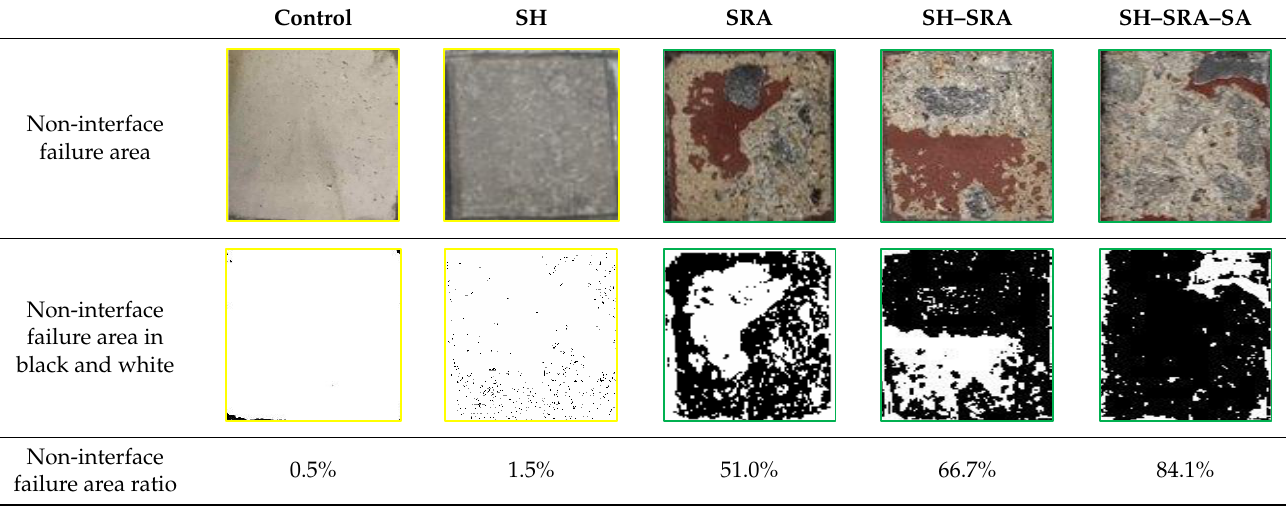
Table 6. Non-interface failure area and ratio according to face treatment conditions. Control